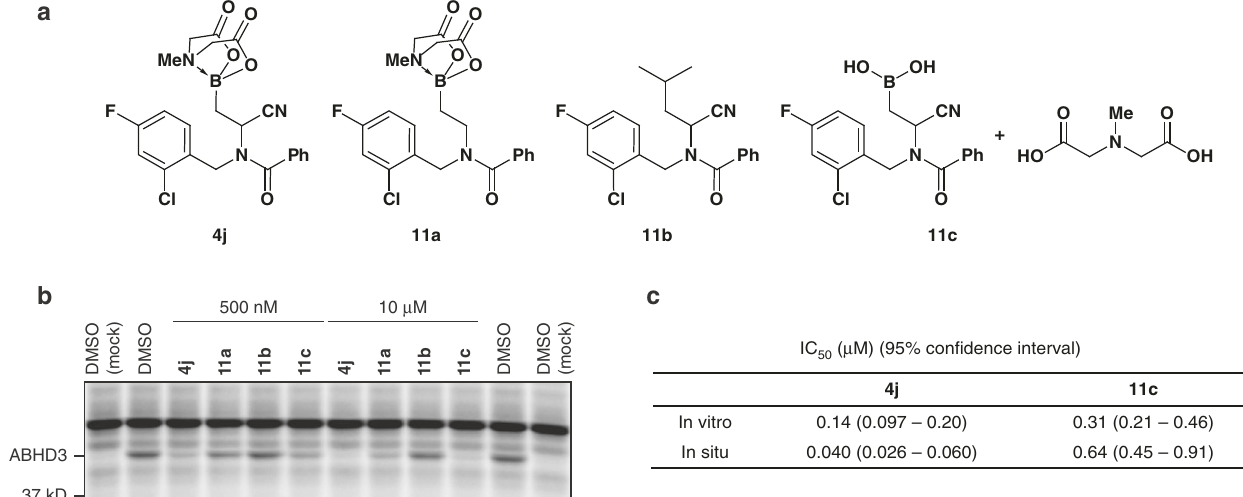
Fig. 6 Structure-activity relationship for inhibition of ABHD3 by compound 4j . a Structure of 4j and analogues. b ABPP gel of HEK 293T cells overexpressing human ABHD3 treated with 4j and analogues in vitro. c IC 50 values determined by gel-based ABPP with HEK 293T cells overexpressing human ABHD3. The data represent average values ± 95% con fi dence intervals from three independent experiments per